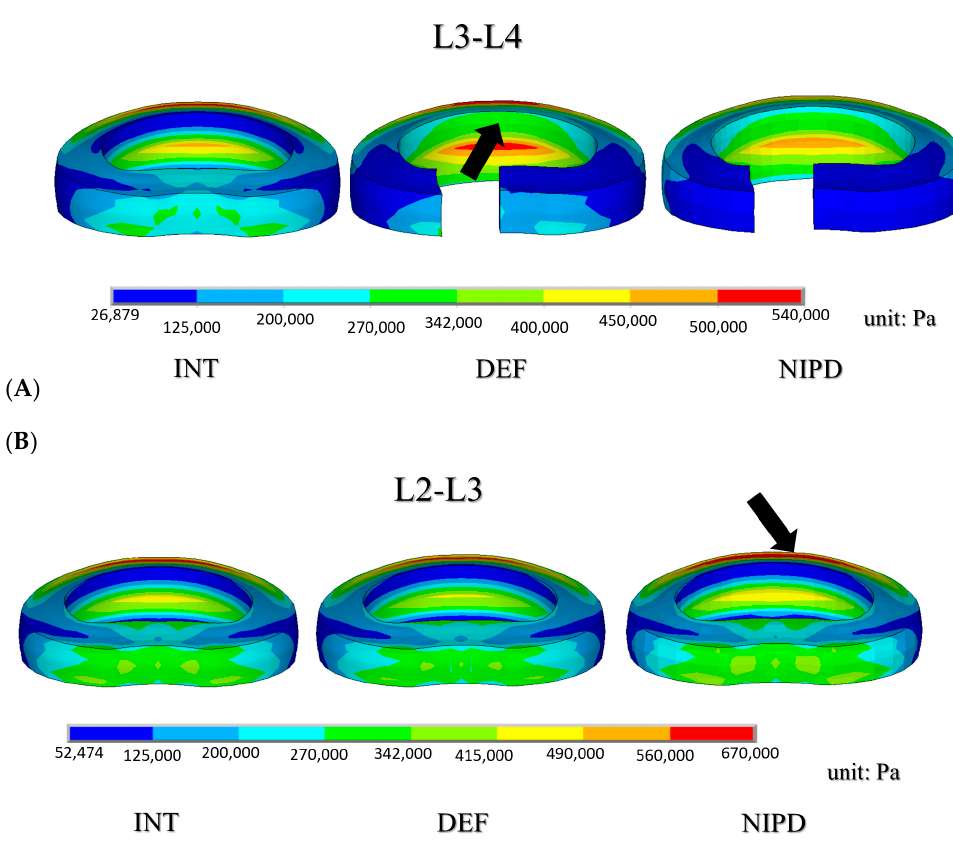
Figure 5. Disc stress distributions in the three FE models during flexion: ( A ) implanted level L3–L4 and ( B ) adjacent level L2–L3. Note: the arrow indicates the region of high stress.